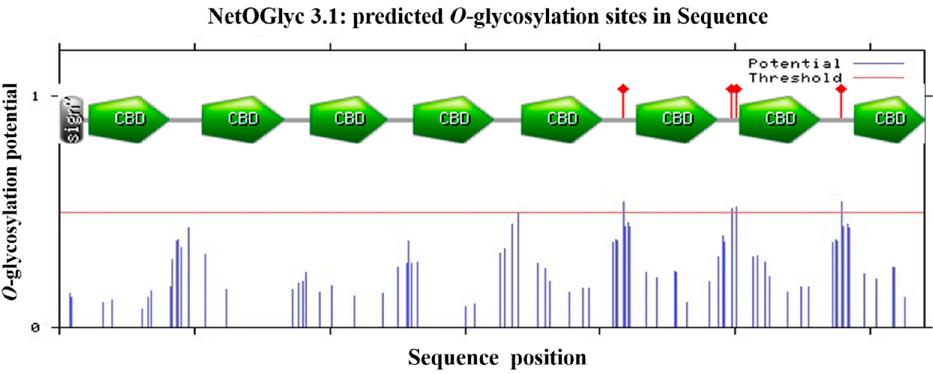
Figure 2. Schematic structures of the HpCBP45 and prediction analysis of glycosylation site. Functional domains were analyzed by Expasy prosite database. Residues with an -glycosylation potential exceeding the threshold level (red line) are expected to be glycosylated. Sign, signal peptide sequence; CBD, chitin-binding domain; Asn-Xaa-Ser/Thr sequons in the sequence output below are highlighted in